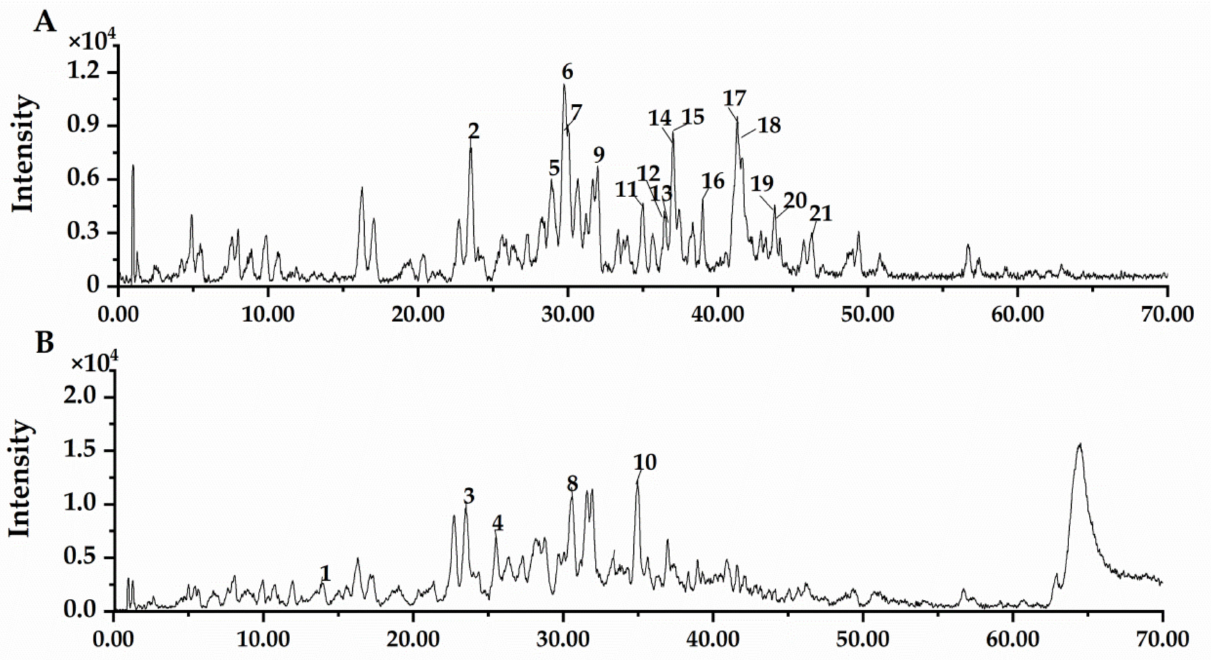
Figure 1. UPLC-ESI-MS total ion current chromatogram of n-butanol fraction of Ficus tikoua (NBF). ( A ) Total ion current chromatogram in the negative ion mode. ( B ) Total ion current chromatogram in the positive ion